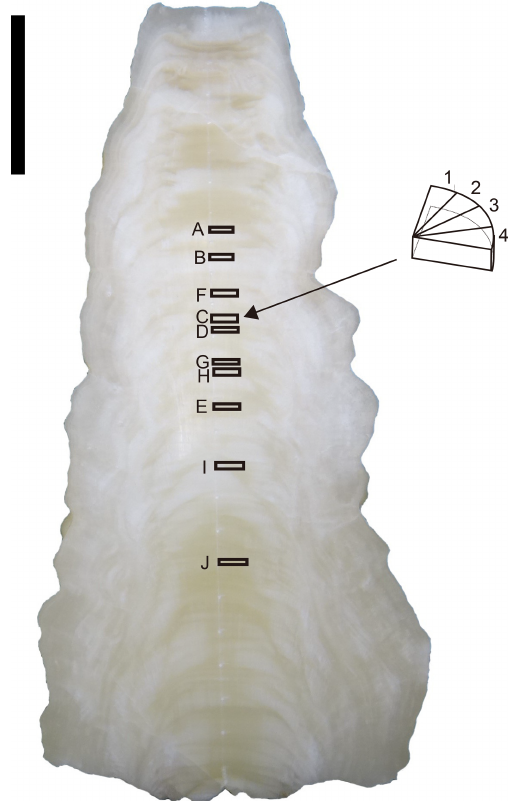
Figure 1. Photograph of HSN1 stalagmite. Half section of the HSN1 stalagmite from Hoshino Cave. The horizontal bar represents 5cm. The positions of samples (A–J) used for the experiments are shown as bold black boxes. An example of wedge-shaped subsam- ples from a layer is illustrated